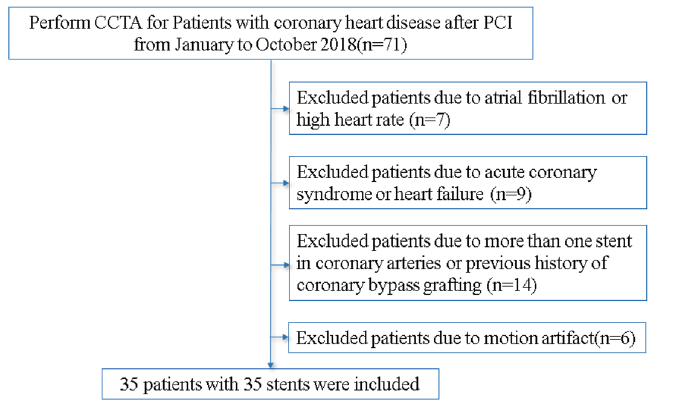
Figure 5. Flow diagram of patient